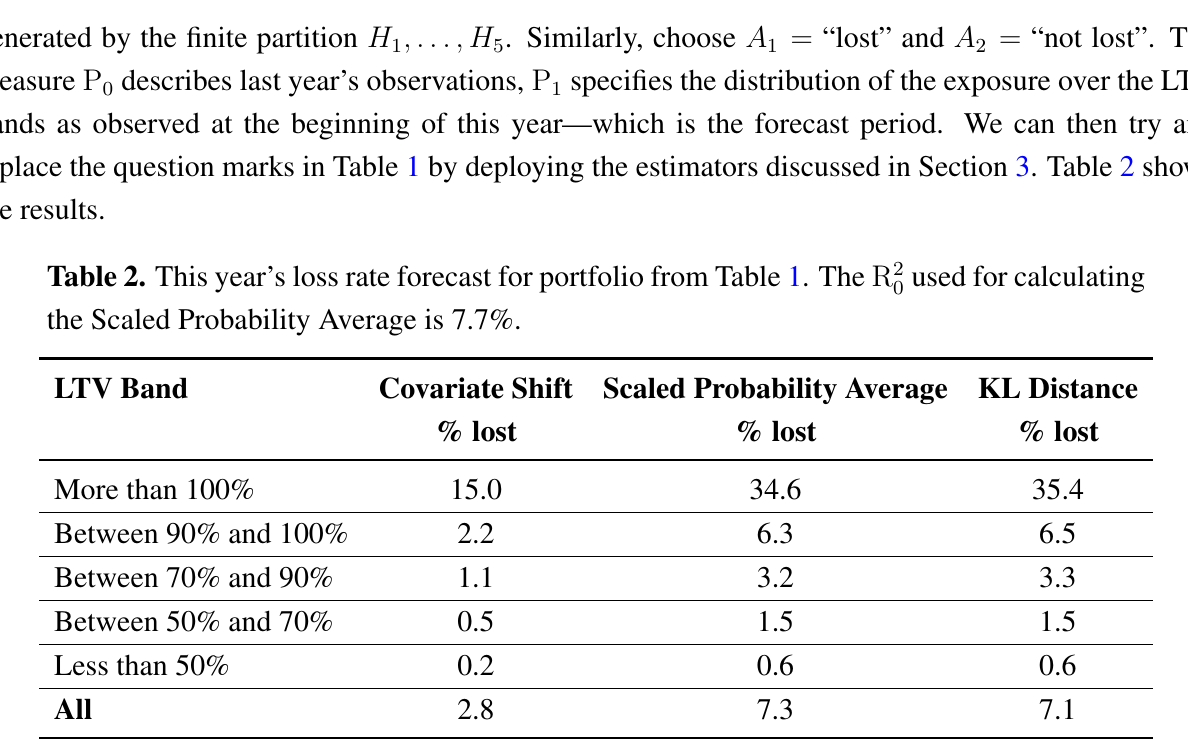
used for calculating 0